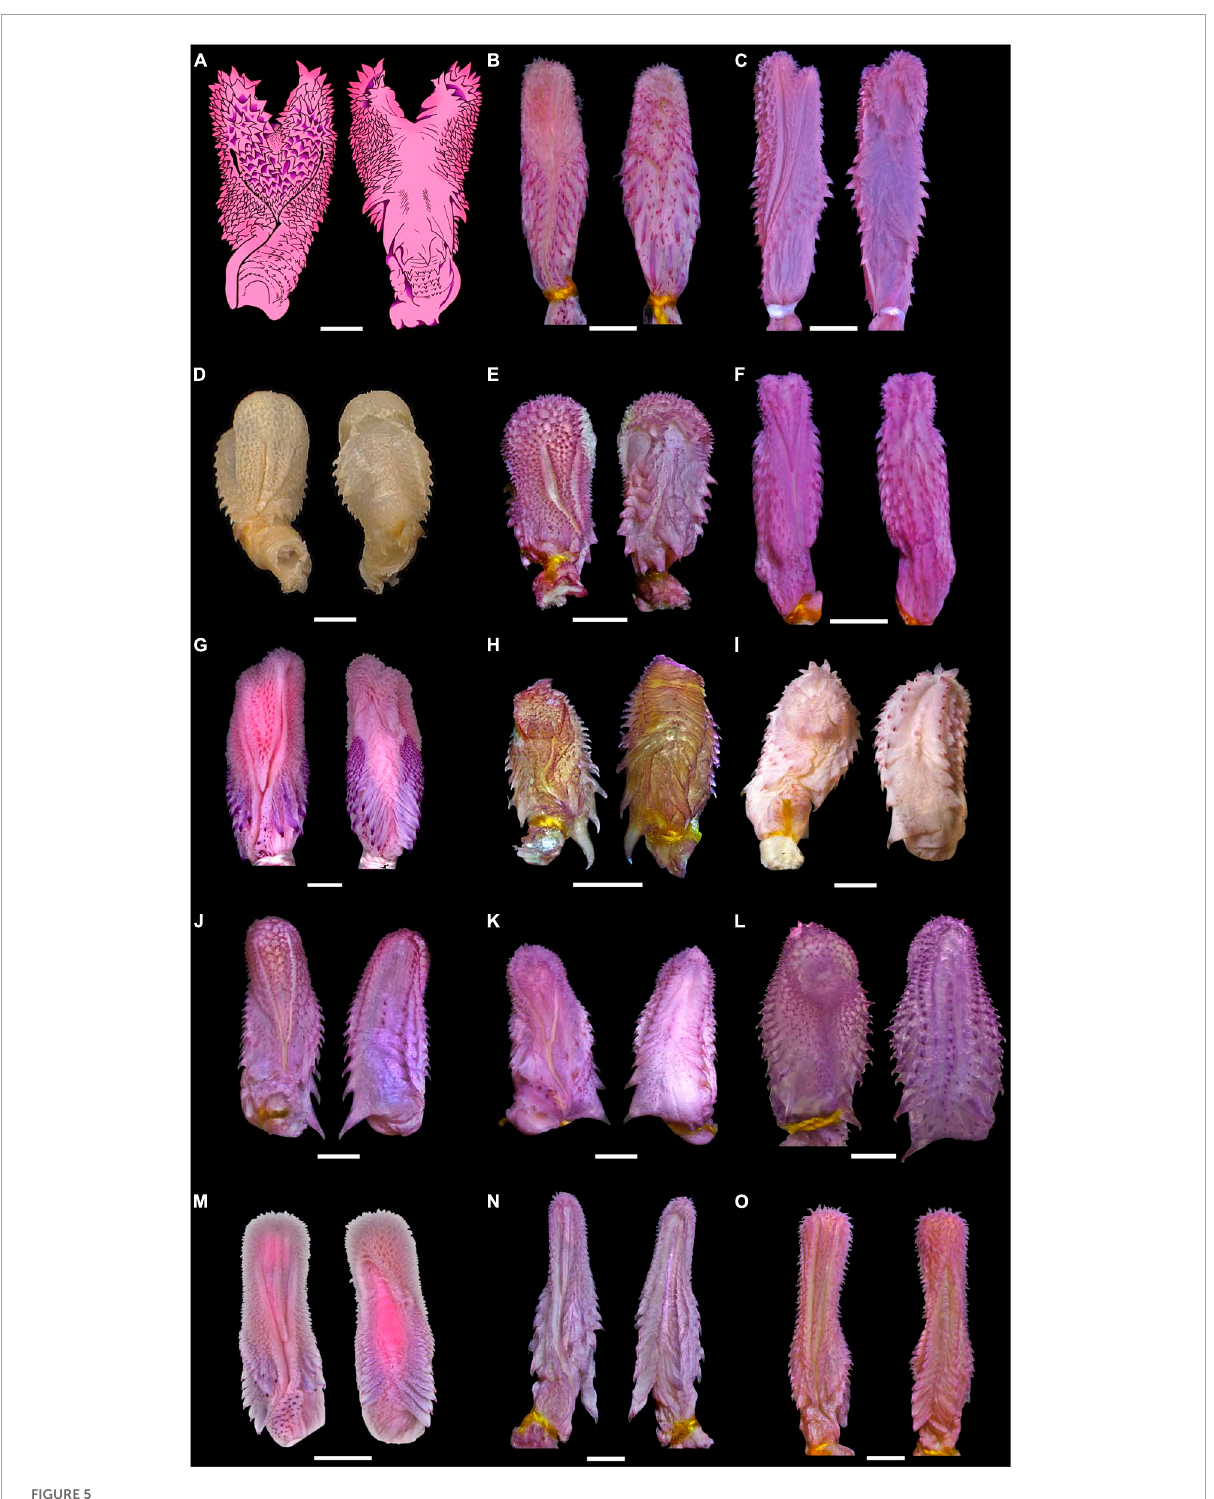
FIGURE5 Comparative hemipenial morphology among the evaluated genera. (A) Myersinia nebularis (MHNLS 15743) redrawn from Schargel et al. (2005); (B) Taeniophallus nicagus (IBSP 91656); (C) Taeniophallus brevirostris (MPEG 8639); (D) Adelphostigma quadriocellata (MPEG 8272); (E) Adelphostigma occipitalis (DZUFRGS 6466); (F) Sordellina punctata (IBSP 84433); (G) Amnisiophis amoenus (UFMG 3272); (H) Dibernardia poecilopogon (DZUFRGS 5973); (I) Dibernardia persimilis (IBSP 55279); (J) Dibernardia affinis (IBSP 51561); (K) Dibernardia bilineata (IBSP 82065); (L) Echinanthera undulata (IBSP 92283); (M) Echinanthera melanostigma (UFMG 3273); (N) Echinanthera cyanopleura (IBSP 81751); and (O) Echinanthera cephalostriata (URCA 4103). Scale bars: 2